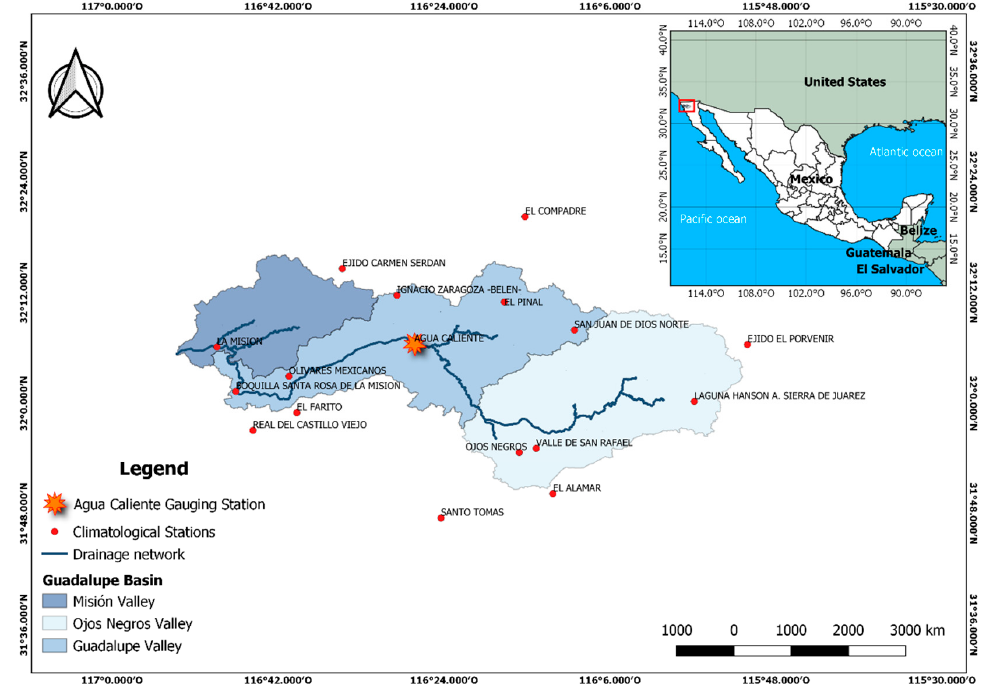
Figure 1. Study Area Location.